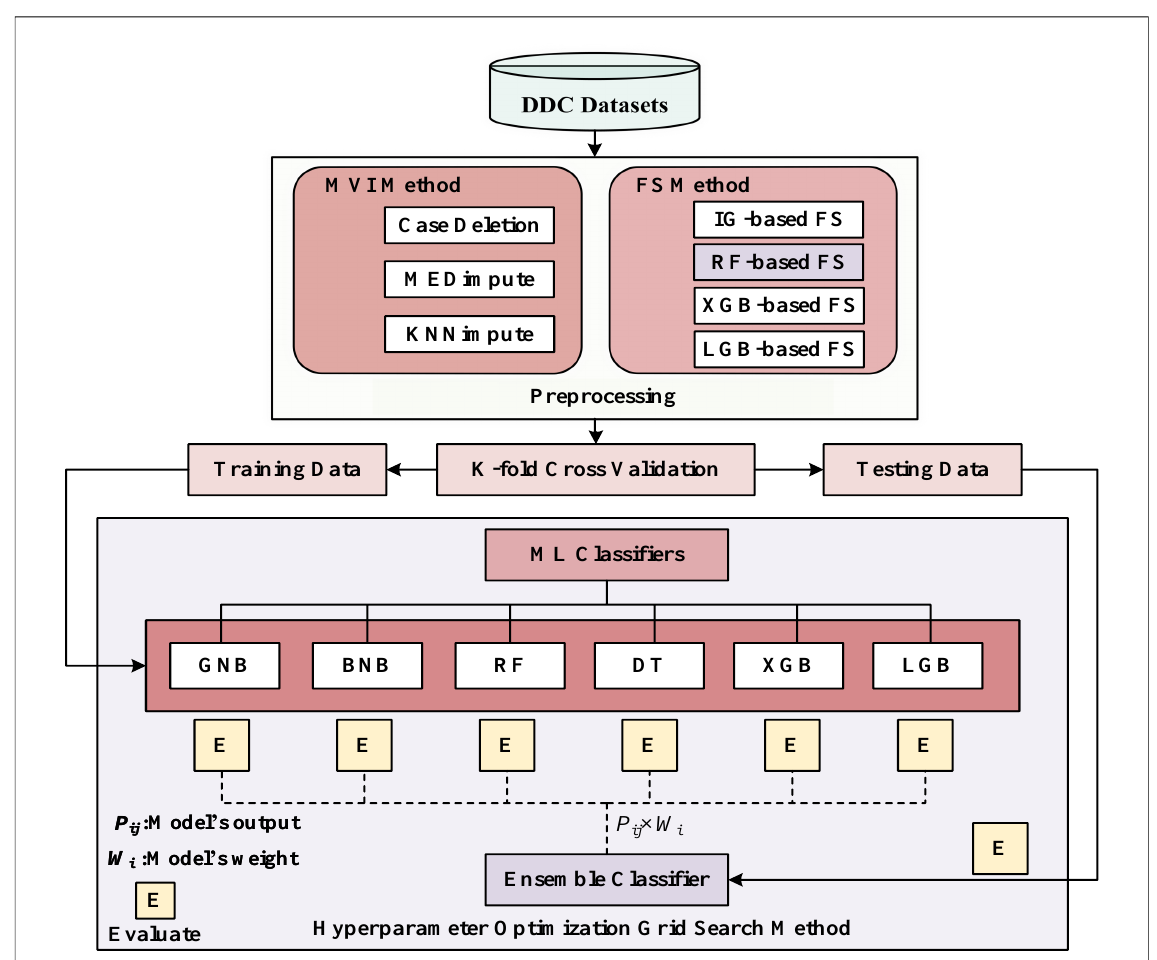
Figure 1. Block diagram of the proposed workflow incorporating various ML-based classifiers, a pre-processing step, and hyperparameter tuning through grid search